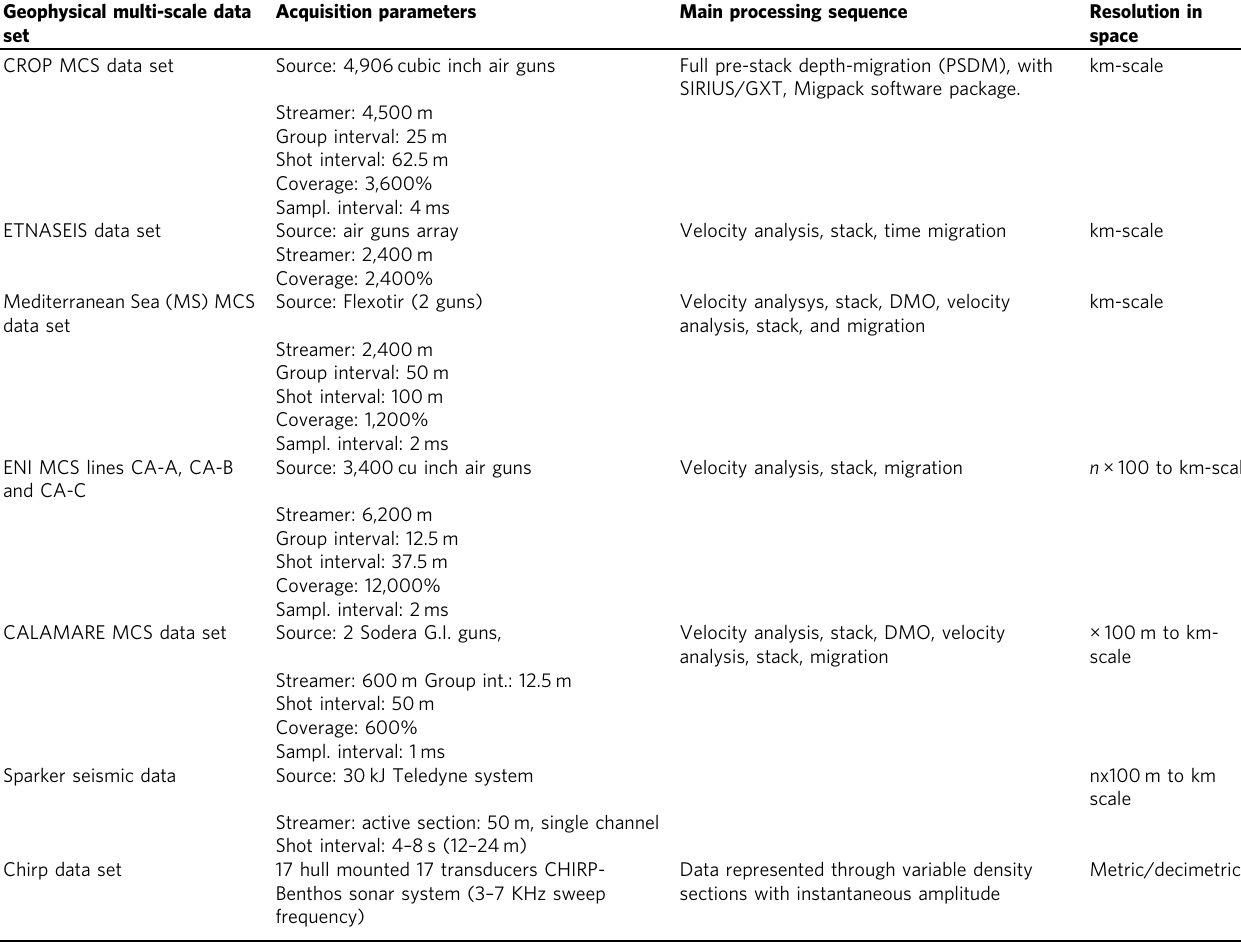
Table 1 Acquisition parameters, processing sequence and resolution of geophysical data used in this study Geophysical multi-scale data Acquisition set